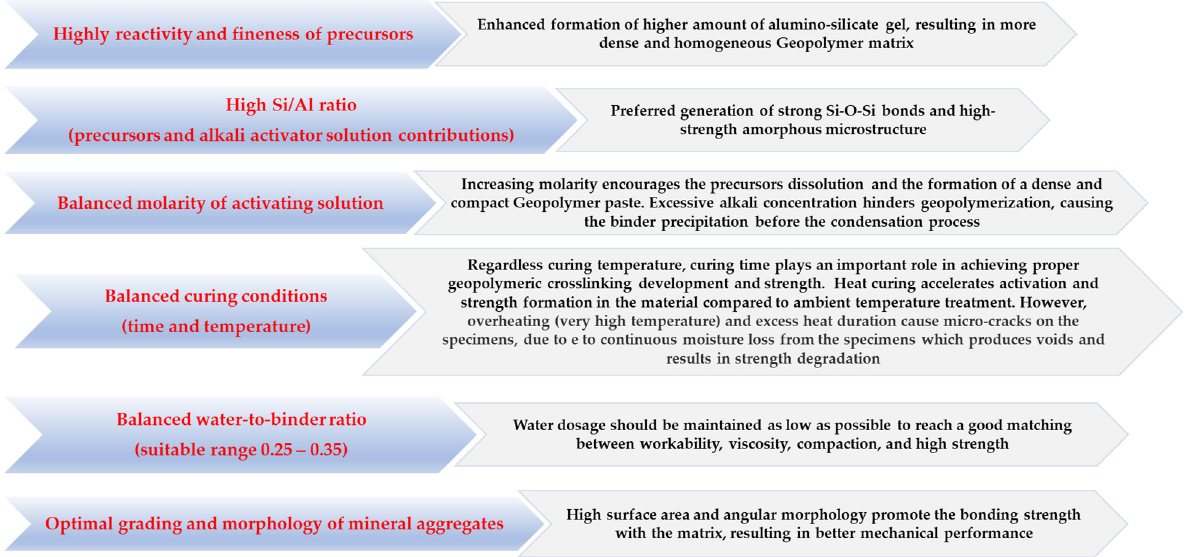
Figure 12. How the synthesis parameters optimize the strength properties of GC composites. Table 3. Effect of process variables on the mechanical properties of geopolymer concrete/mortars.